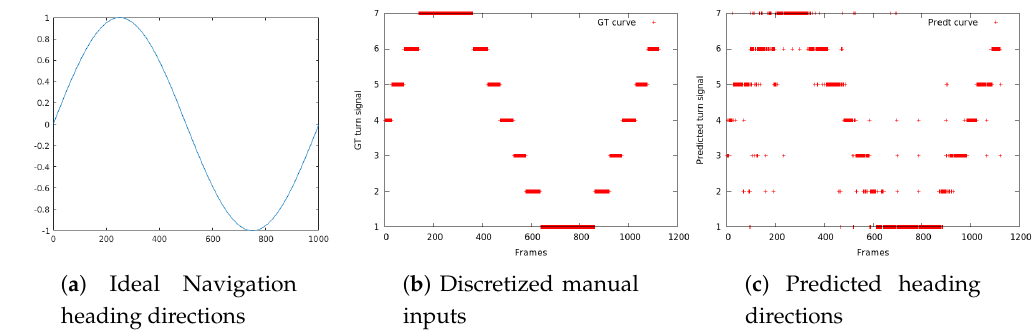
Figure 9. Robot Navigation Simulation. X-axis: frame index; Y-axis: sine of heading direction angle. The ideal, manually selected navigation path in ( a ) covers the entire possible heading direction angle y n , from 0 ◦ to 90 ◦ , then − 90 ◦ and back to 0 ◦ . Therefore, sin ( y n ) covers [ − 1,1 ] . ( b ) Limited by